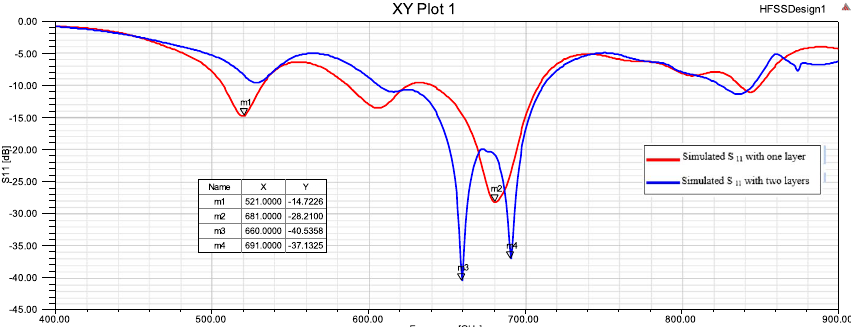
Fig. 16 Reflection coefficients of microstrip patch antenna with dielectric